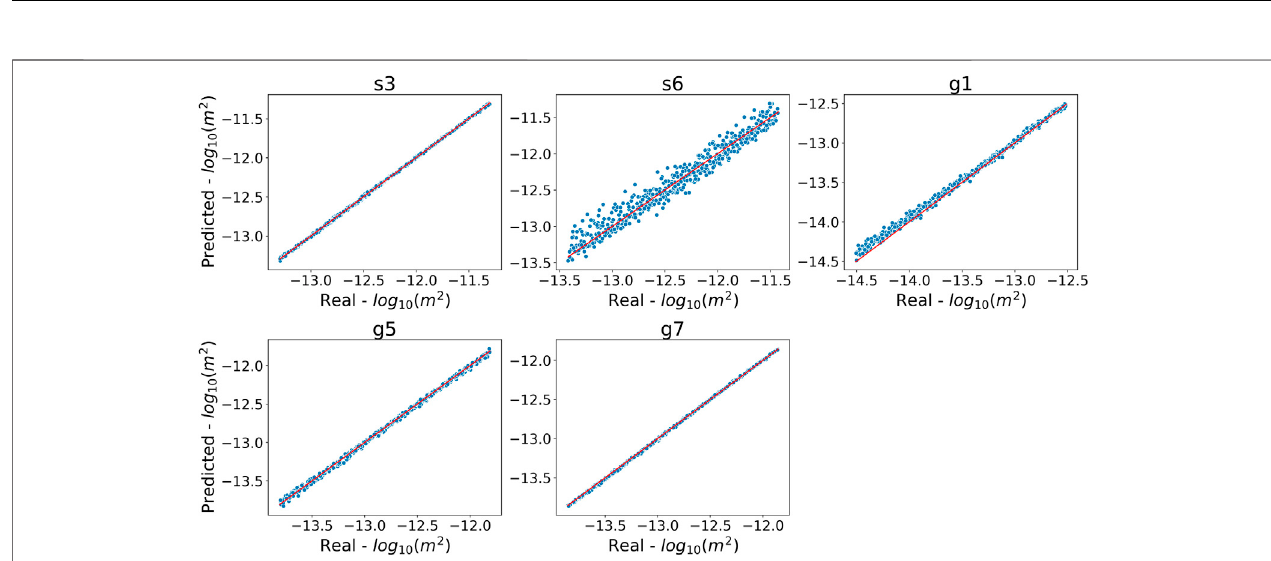
FIGURE4| One-to-oneplotoftheDNNA3modelpermeabilityestimationwhencomparedtotherealestimationforthetrainingset.EachplotistheDNNA3model estimation for the given permeability parameter. Each dot represents a realization from the training set of ensembles. The x -axis is the log 10 real permeability value, the y-axis is the log 10 estimated permeability value from the model. The red line is the one-to-one line.